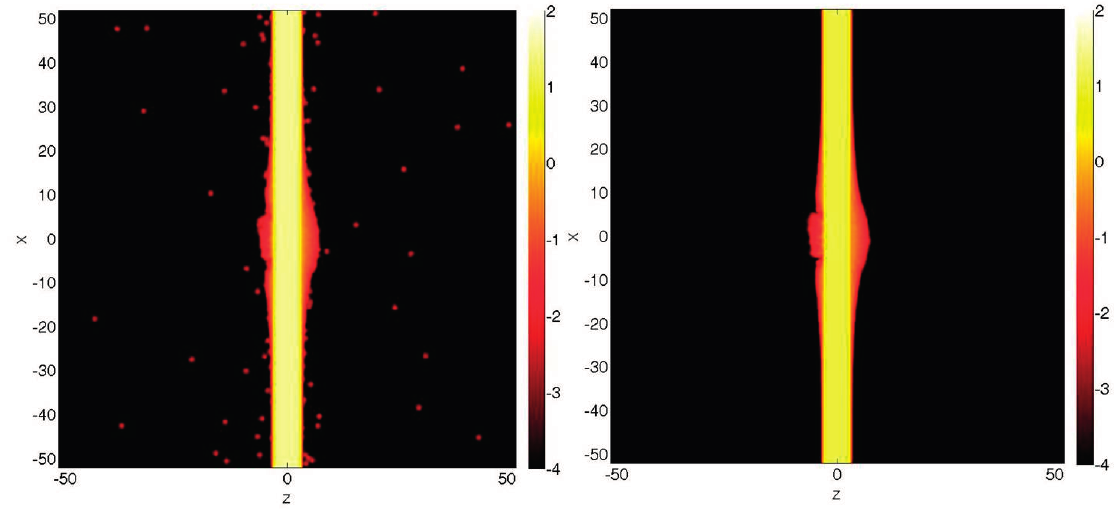
Figure 8. Electrons ( left ) and protons ( right ) spatial distributions obtained by simulation of the interaction of a laser pulse of intensity 2.5 × 10 19 W/cm 2 , with ellipsoidal shape constant density whisker. X, Y axes are in μ m. Color map scale is logarithmic normalized related to the critical